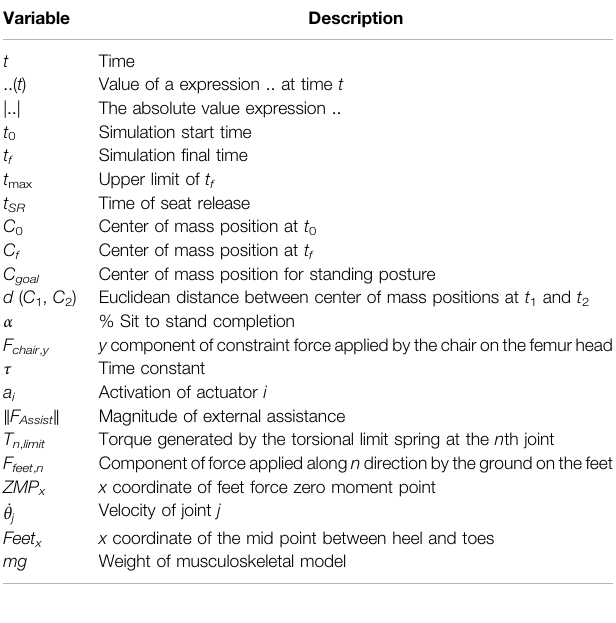
TABLE 2 | List of